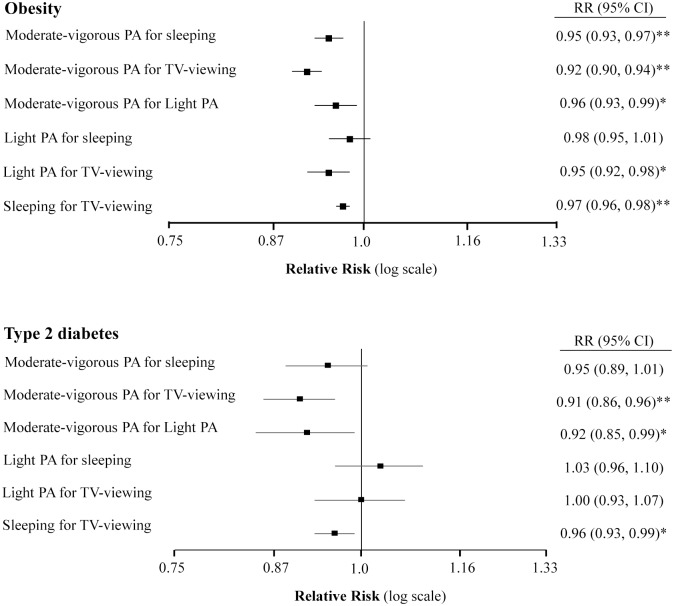
RR (95%CI) for obesity and diabetes to 60-min/day substitution among sleeping, TV-viewing and PA (n = 5776).Abbreviations: RR, Relative Risk; CI, confidence interval; PA, physical activity. Light PA (<4.0 METs) includes leisurely stroll or walk, Moderate-vigorous PA (≥4.0 METs) includes faster walking, cross country walking, stair climbing, working in the garden, guided exercises and outdoor sports or at home or at the gym. Multivariable model adjusted for age (continuous), sex, education level (illiterate/primary education, secondary education and academic/graduate), smoking status (never smoker, past smoker and current smoker), marital status (single/divorced, married and widower), familiar story of coronary hearth disease (yes or no) and Mediterranean diet adherence (<8 or ≥9 items). All models were stratified by recruiting center. P-value * < .05, ** < .01.